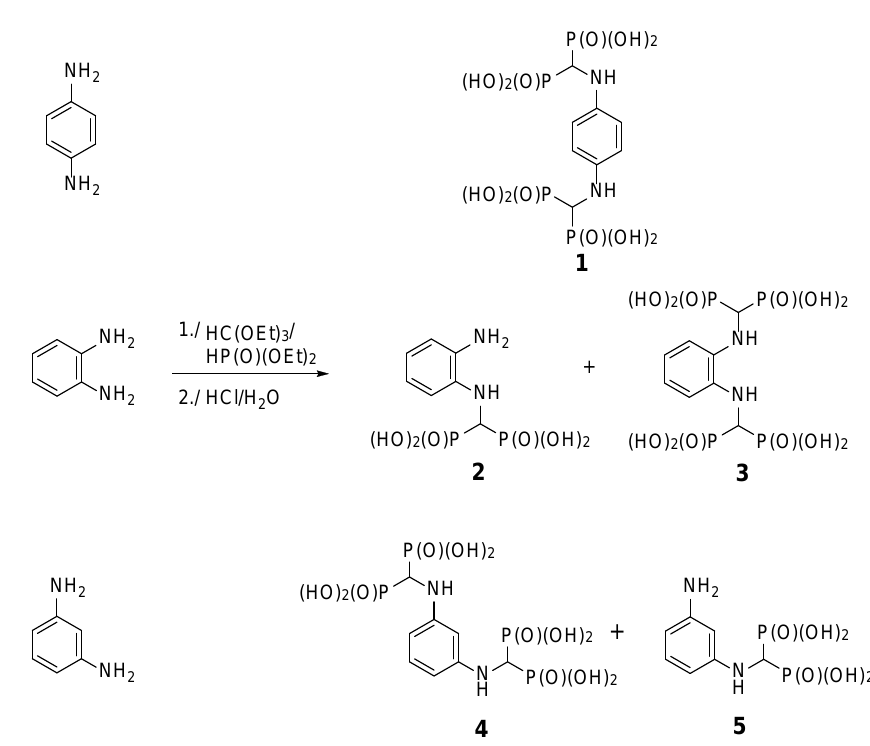
Figure 1. Three-component reaction of diaminobenzenes with triethyl orthoformate and diethyl phosphite.